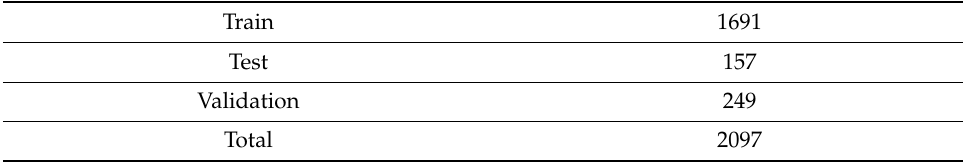
Table 2. Numbers of images for UBD Botanical dataset.